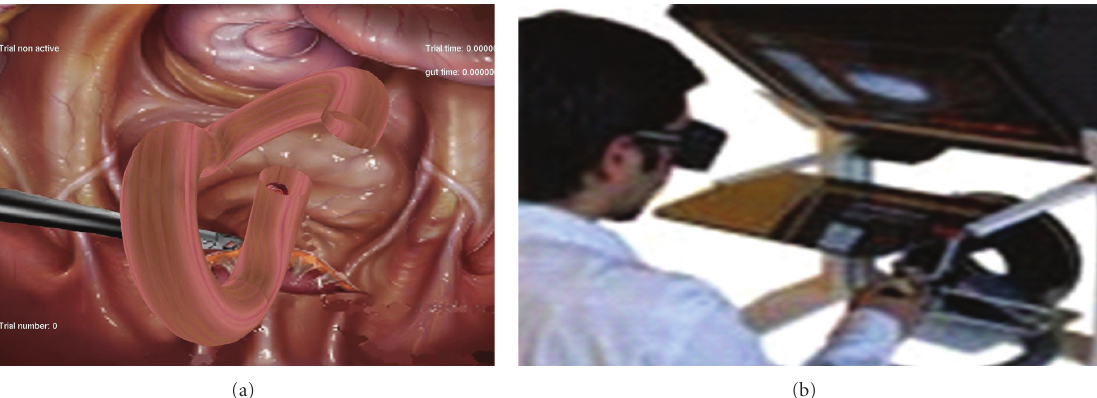
Figure 1: (a) A (2D) screen-shot showing the virtual intestine embedded in a virtual abdomen. Overlaid text provides additional feedback to the participant: amount of trials elapsed, time from the beginning of the trial and the accumulated time of touching the intestine’s wall. (b) the Virtual 3D collocated